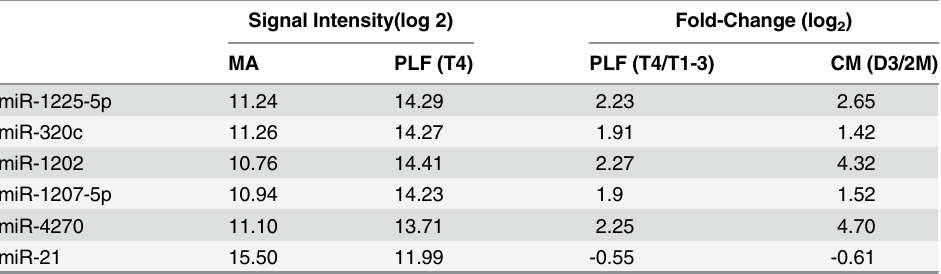
Table 3. Signal intensity and fold-change of the miRNAs. Malignant ascites (MA); Peritoneal lavage fluid (PLF); Condition medium (CM), T stage UICC 7 th edition (T4, T1-3); OCUM-2M (2M); OCUM-2MD3 (D3).